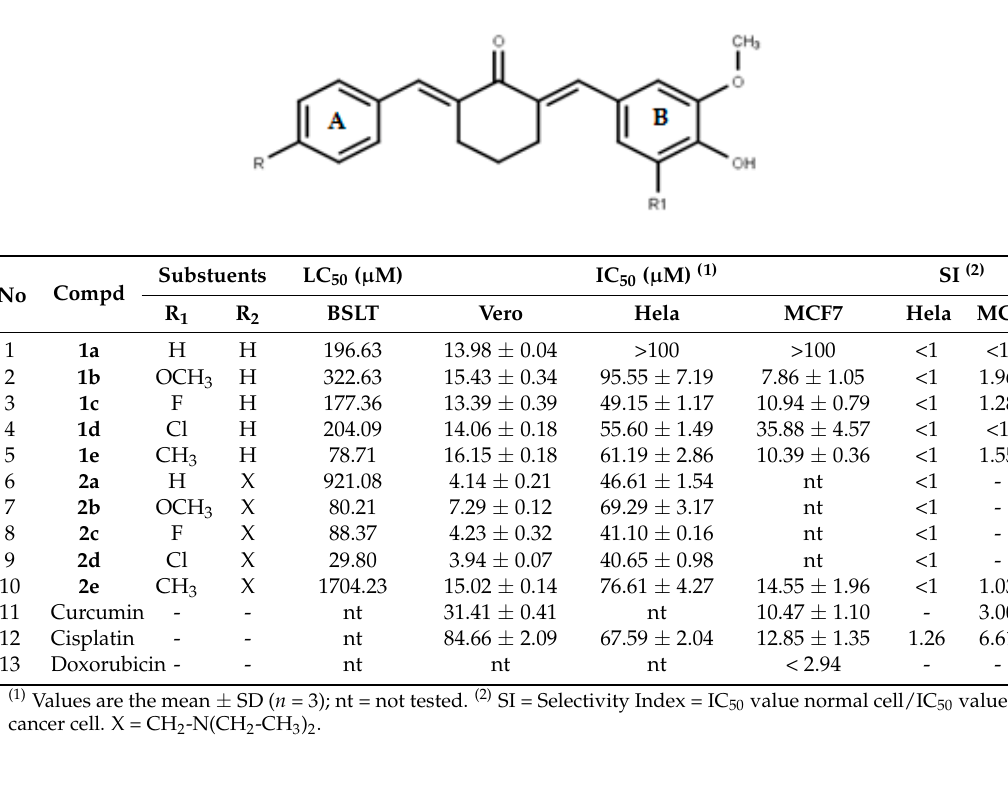
Table 1. Cytotoxicity of the synthesized compounds against brine shrimp and Vero, Hela, and MCF7 cell lines.